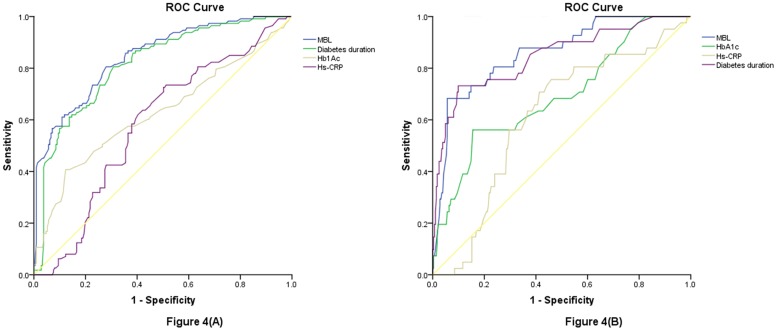
Receiver operating characteristic (ROC) curves were utilized to evaluate the accuracy of markers to diagnoseDR or VDTR.(A) Receiver operator characteristic curve demonstrating sensitivity as a function of 1-specificity for diagnosing the DR based on the MBL, Hs-CRP, HbA1c anddiabetes duration; (B) Receiver operator characteristic curve demonstrating sensitivity as a function of 1-specificity for diagnosing the VDTR based on the MBL, Hs-CRP, HbA1c anddiabetes duration.